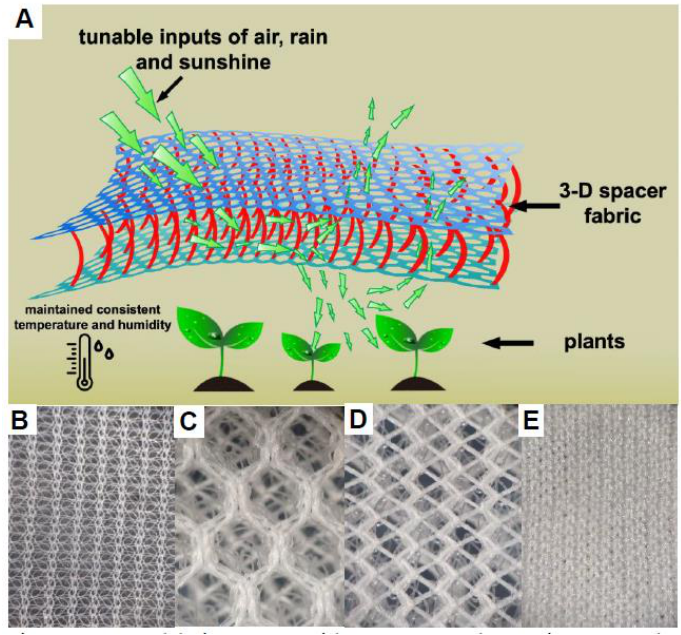
Figure 2. ( A ) Model of a 3-D spacer fabric as an insect barrier for crop production; ( B ) Proteknet, a commercially available knitted fabric for plants; ( C , D ) Plant Armor Generation (Gen) 1, a knitted, spacer fabric showing the top with large holes ( C ) and underside facing the covered plants with smaller holes ( D ); and (E) Plant Armor Gen 2, a knitted, spacer fabric that looks the same on both sides. See Materials and Methods for the knitting of Plant Armor Gen 1–2. Magnification is 5X for ( B – E ). The weight per unit area of Proteknet was 3.23 ± 0.04 g/m 2 , Plant Armor Gen 1 was 49.21 ± 1.63 g/m 2 , and Plant Armor Gen 2 was 14.59 ± 0.10 g/m 2 (Figure 3A; F =